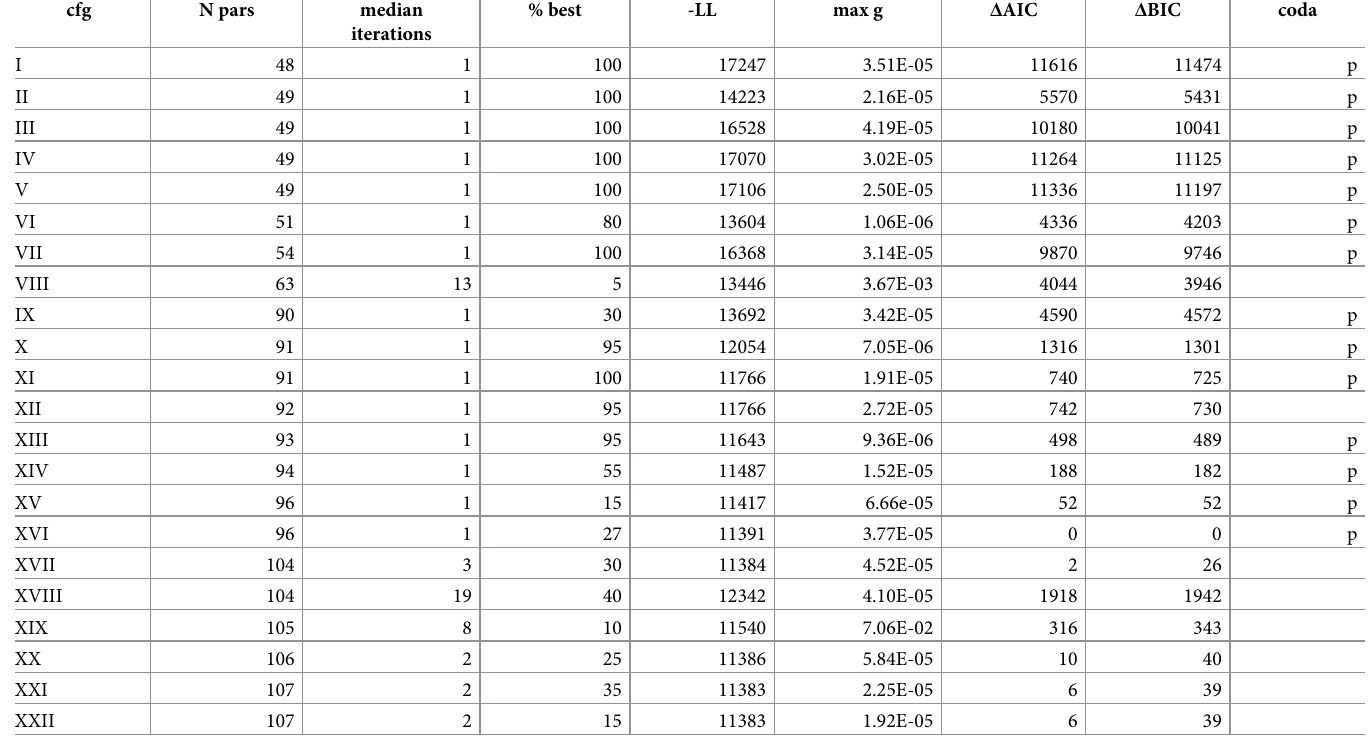
Table 3. Model fit, consistency and convergence properties for the 22 configurations in Table 2. The number of estimated parameters (N pars), median number of phase randomizations (iterations) before an invertible Hessian was obtained, percentage of the series of replicates that had the lowest objective value (% best), the lowest negative log-likelihood (-LL), maximum gradient (max g), Δ AIC, Δ BIC, and whether or not the configuration passed (p) the coda diagnostics are reported.